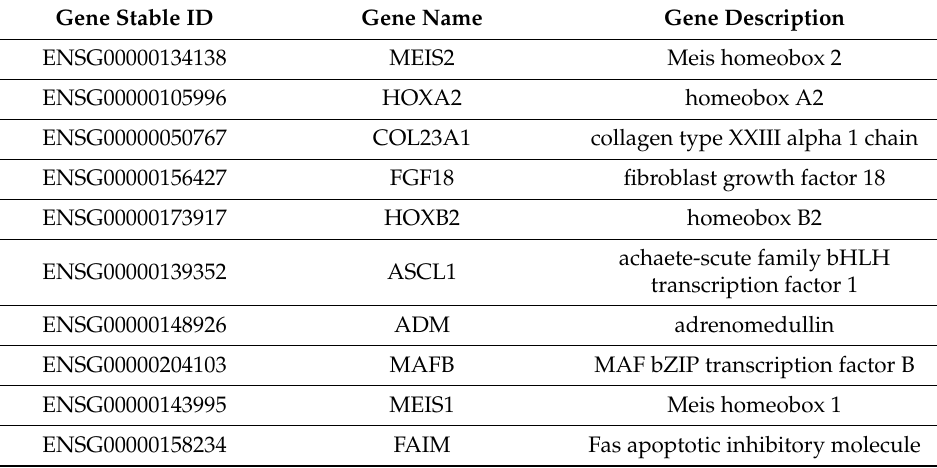
Figure 3. ( A ) Hierarchical clustering of the Alzheimer’s disease (AD) biomarkers identified using the Discriminant Analysis Module (DAM) algorithm in the Induced pluripotent stem cells (iPSCs)-derived neuronal progenitors (NP) cells from sporadic Alzheimer’s disease patients vs. healthy donors (CTRL); ( B ) Principal Component Analysis (PCA) using the identified AD biomarkers on the samples from the GSE118553 dataset; ( C ) Scatterplot showing Principal Component (PC)1 and PC2 for the entorhinal samples from the GSE118553 dataset; ( D ) Scatterplot showing PC1 and PC3 for the entorhinal samples from the GSE118553 dataset. Table 1. List of biomarkers identified by DAM analysis in iPSC-derived NP cells 1 . Gene Stable